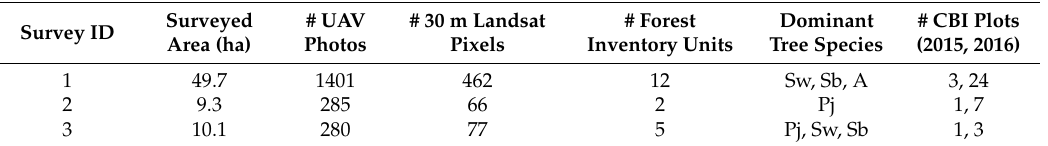
Figure 2. Portion of a 24 megapixel photo taken over survey area #3 using a Sony a6000 camera mounted to an octocopter UAV. Portions of the fire completely consumed the surface organic layer, exposing the bright underlying mineral soil. Table 1. Details of the 2014 burned sites surveyed using an octocopter UAV in early August, 2015. The dominant tree species are listed in decreasing order of percent cover, where Sw = white spruce, Sb = black spruce, A = trembling aspen, and Pj = jack pine.